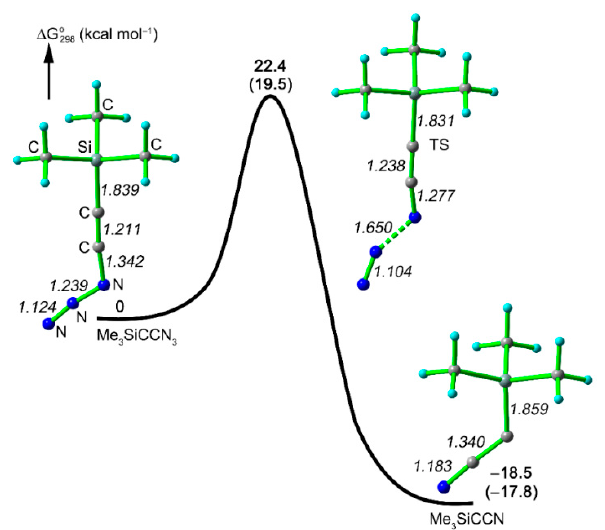
Figure 3. Calculated potential energy surface for the decomposition of Me 3 SiCCN 3 ( 6 ) to generate carbene 8 at the CBS-QB3 and B3LYP/6-311++G(3df,3pd) (in parentheses) levels of theory. The selected bond lengths (Å, italics) calculated at the B3LYP/6-311++G(3df,3pd) level are also shown.